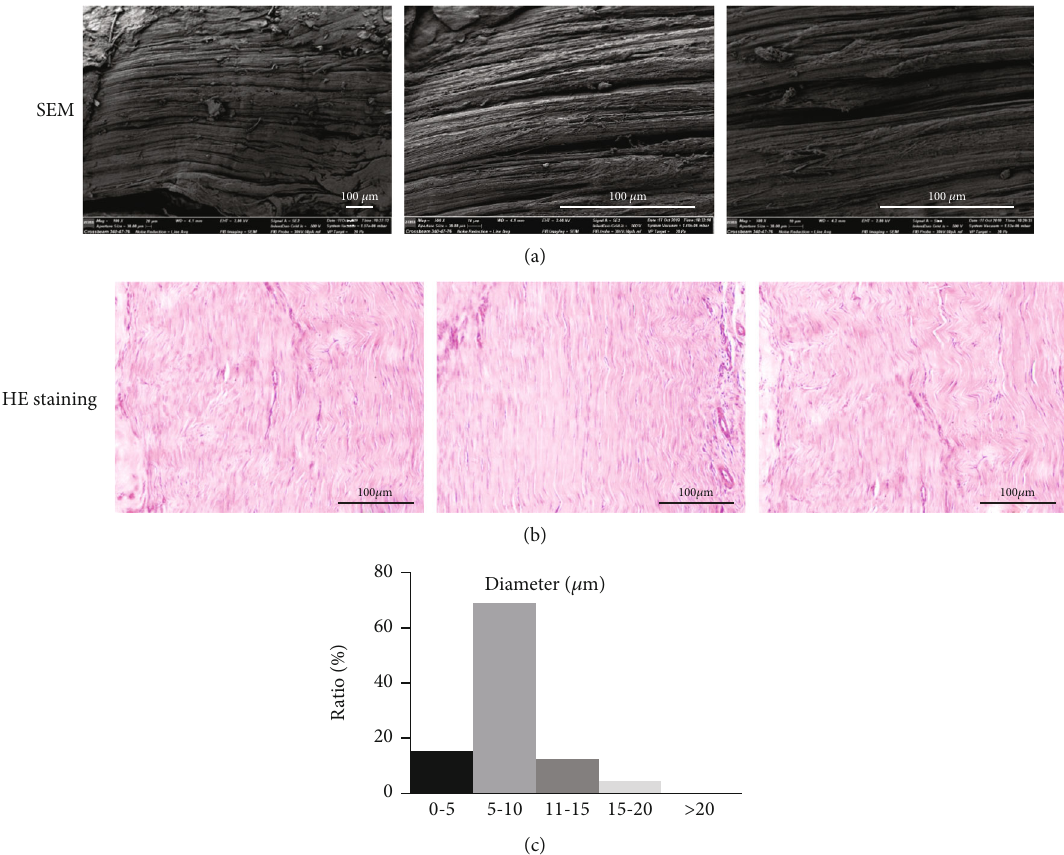
Figure 2: Fibrous structure of native Achilles tendon evaluated with scanning electron microscope (SEM) (a) (magni fi cation at × 100, × 500, and × 500) and HE staining (b) (magni fi cation at × 200). The fi ber diameter distribution of native tendons was measured